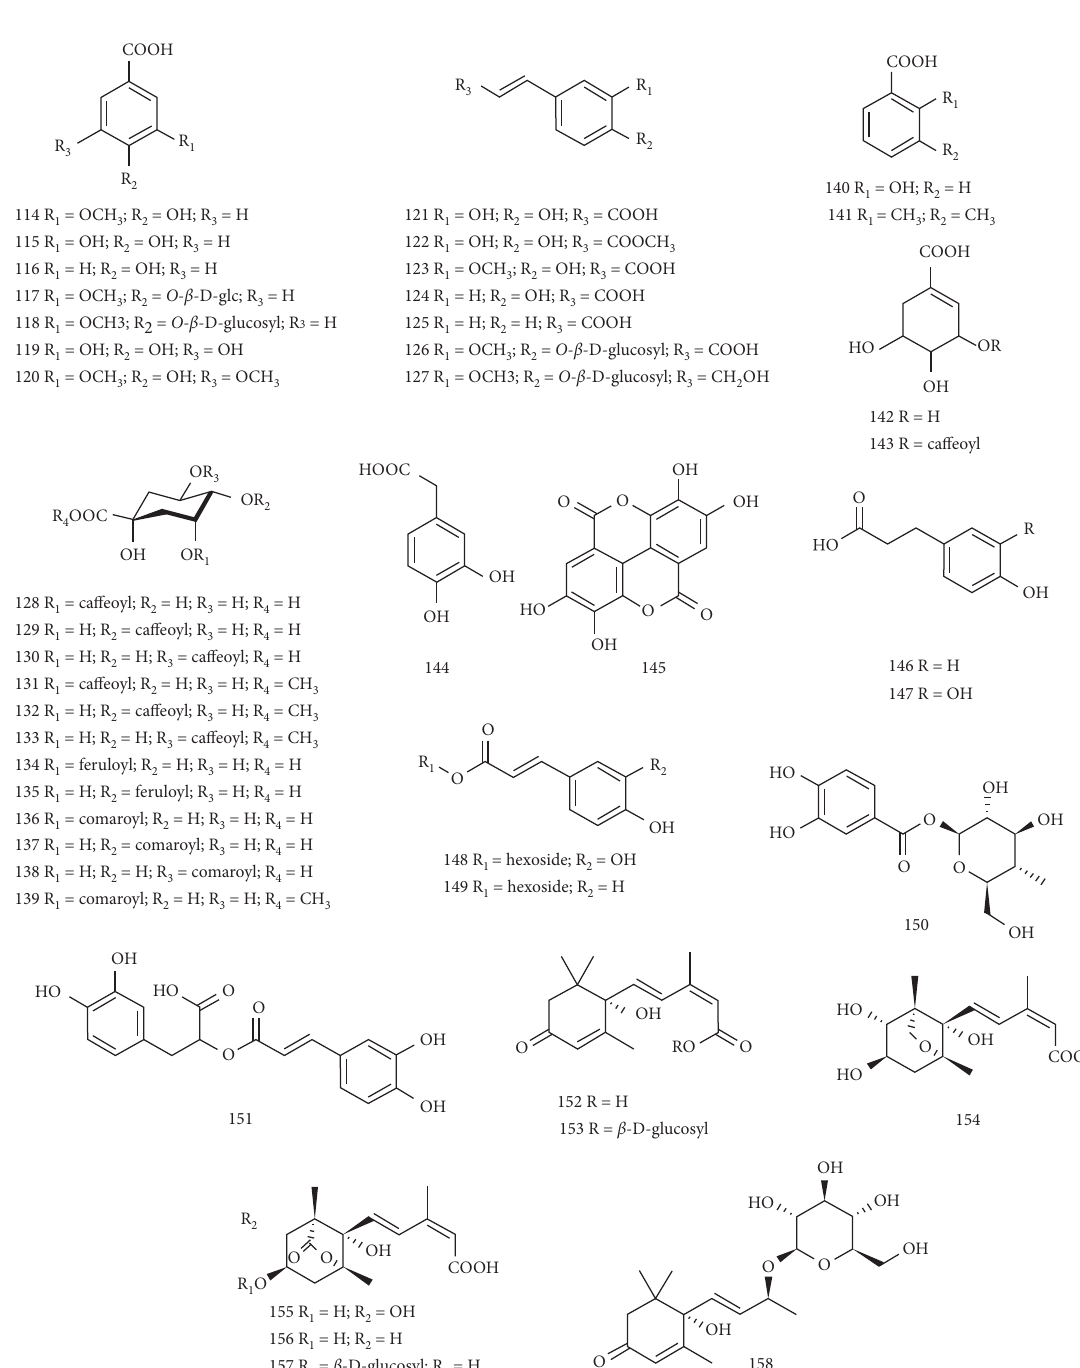
Figure 2: Chemical structures of phenolic acids from Prunus